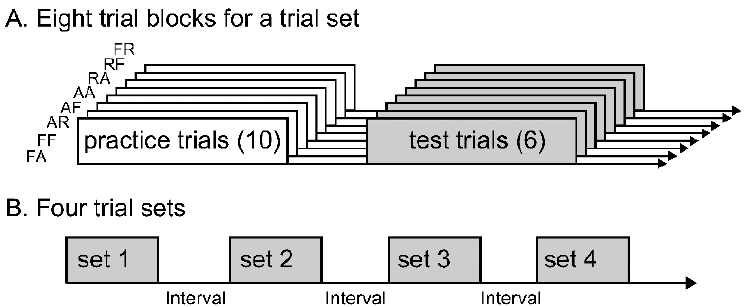
FDI: First dorsal interosseous muscle; ADM: Abductor digiti minimi; F: Flexion; A: Abduction; R: At rest.